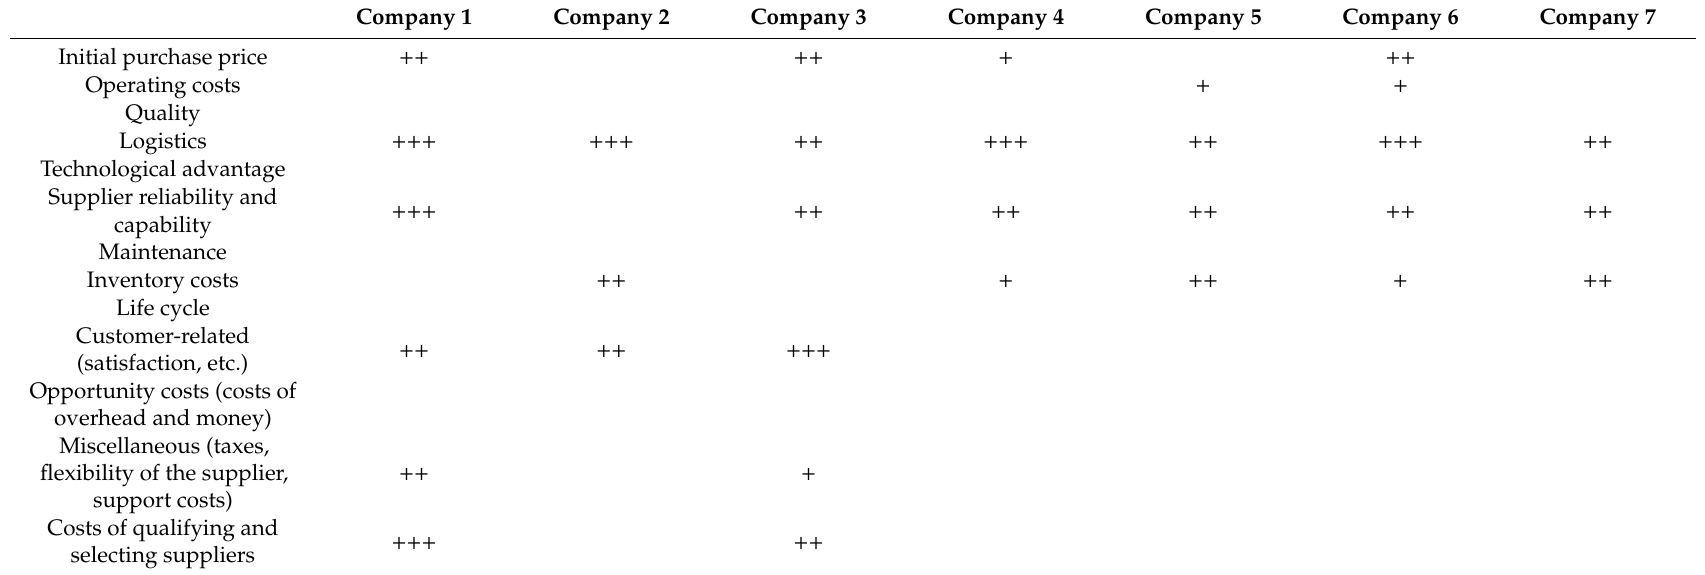
Table 5. Changes in relevance of total costs of ownership (TCO) drivers experienced by case